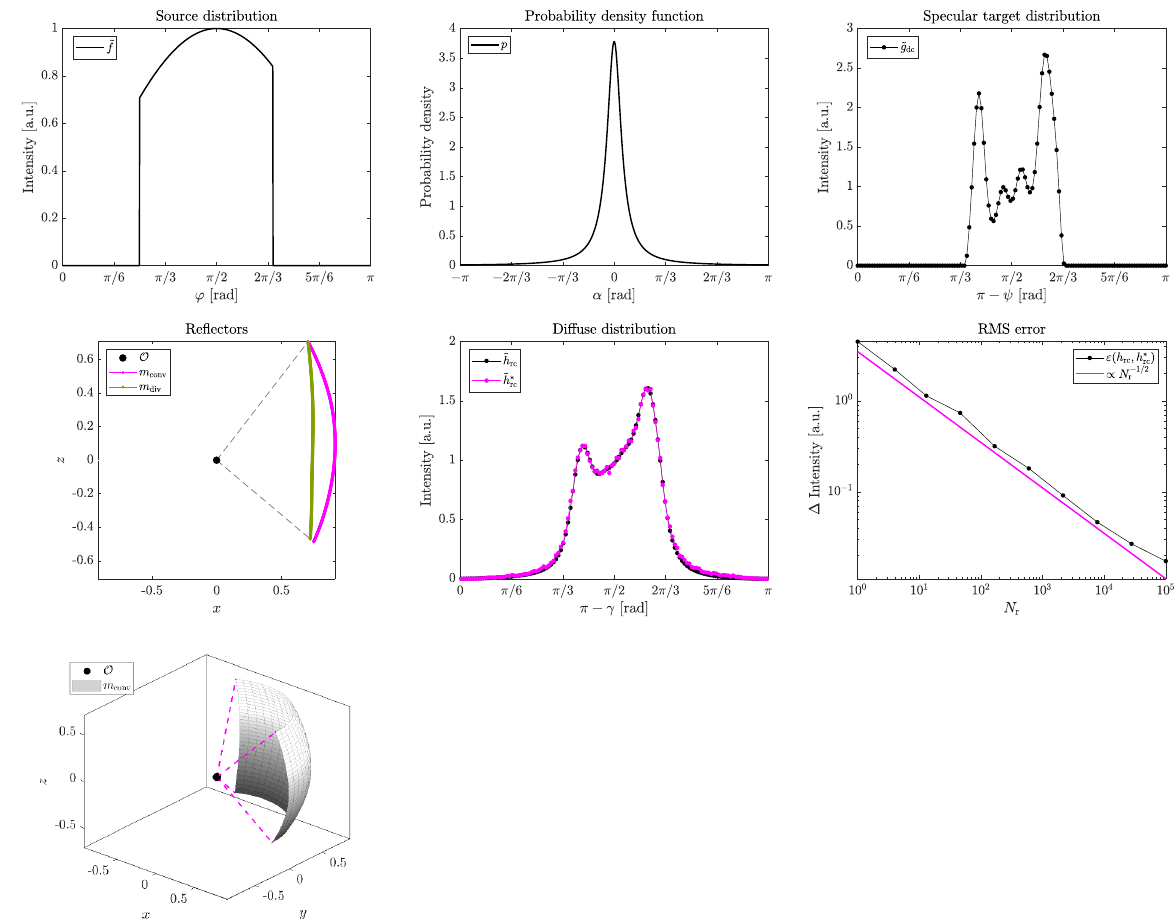
Figure 5. Example of rotationally symmetric reflector design procedure. The prescribed di ff use distribution ˜ h rc is achieved, and the raytraced distribution (roughly) converges with the expected square-root behaviour. The 3D representation of m conv is included for the sake of